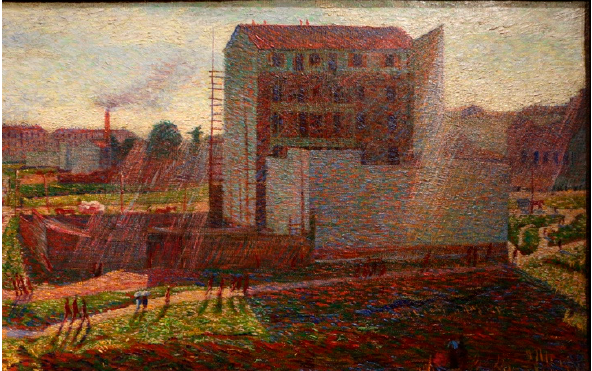
Figure 2. Detail of the painting Officine a Porta Romana, by Umberto Boccioni (1908) representing the raising of industrial compound of Milan.